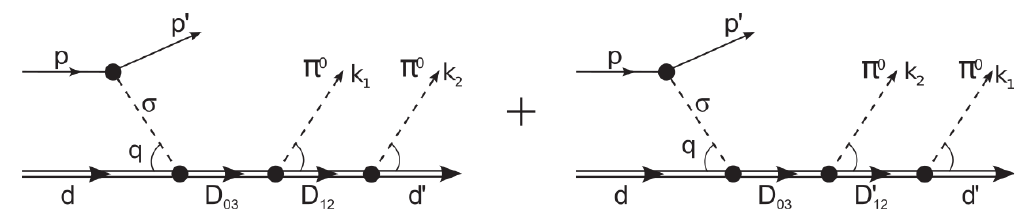
Figure 1: Two resonance mechanism of the reaction pd → pd ππ